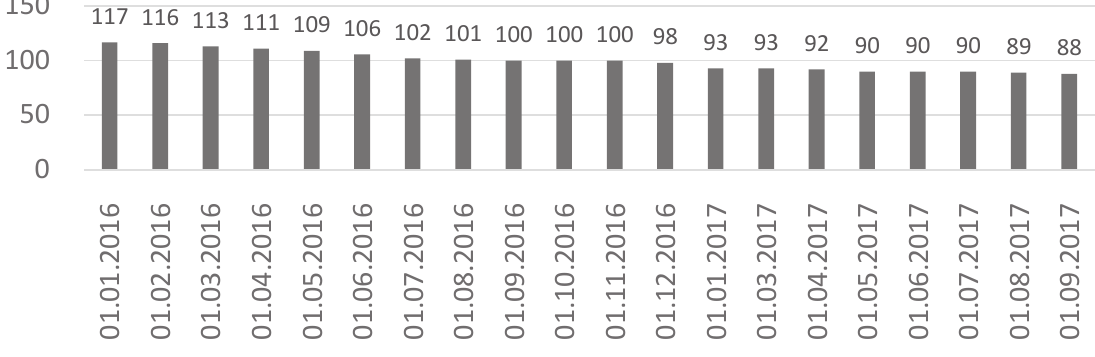
Figure 1. Number of operating banks of Ukraine in 2016–September